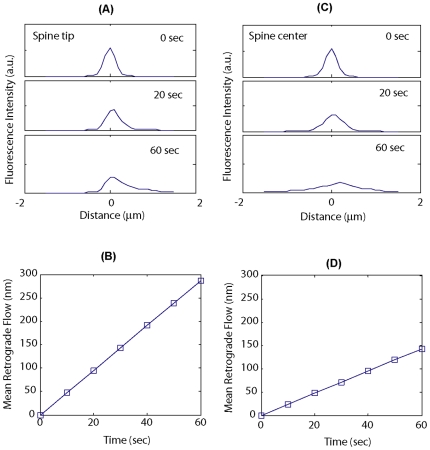
F-actin redistribution in the dendritic spine modeled on single-molecule kinematics measurements.(A) The redistribution of a pool F-actin initially at a spine tip over one minute time span. The initial spread of the molecules is assumed to be diffraction-limited (full-width at half-maximum (FWHM)  = 300 nm). The intensity profile evolves over time, calculated according to the distribution of Sv values from single-molecule measurements. (B) Calculated net retrograde flow of F-actin based on the simulated data in A. (C) The redistribution of a pool F-actin initially at the center of a spine over one minute time span. (D) Calculated net retrograde flow of F-actin based on the simulated data in C. See text for the details.